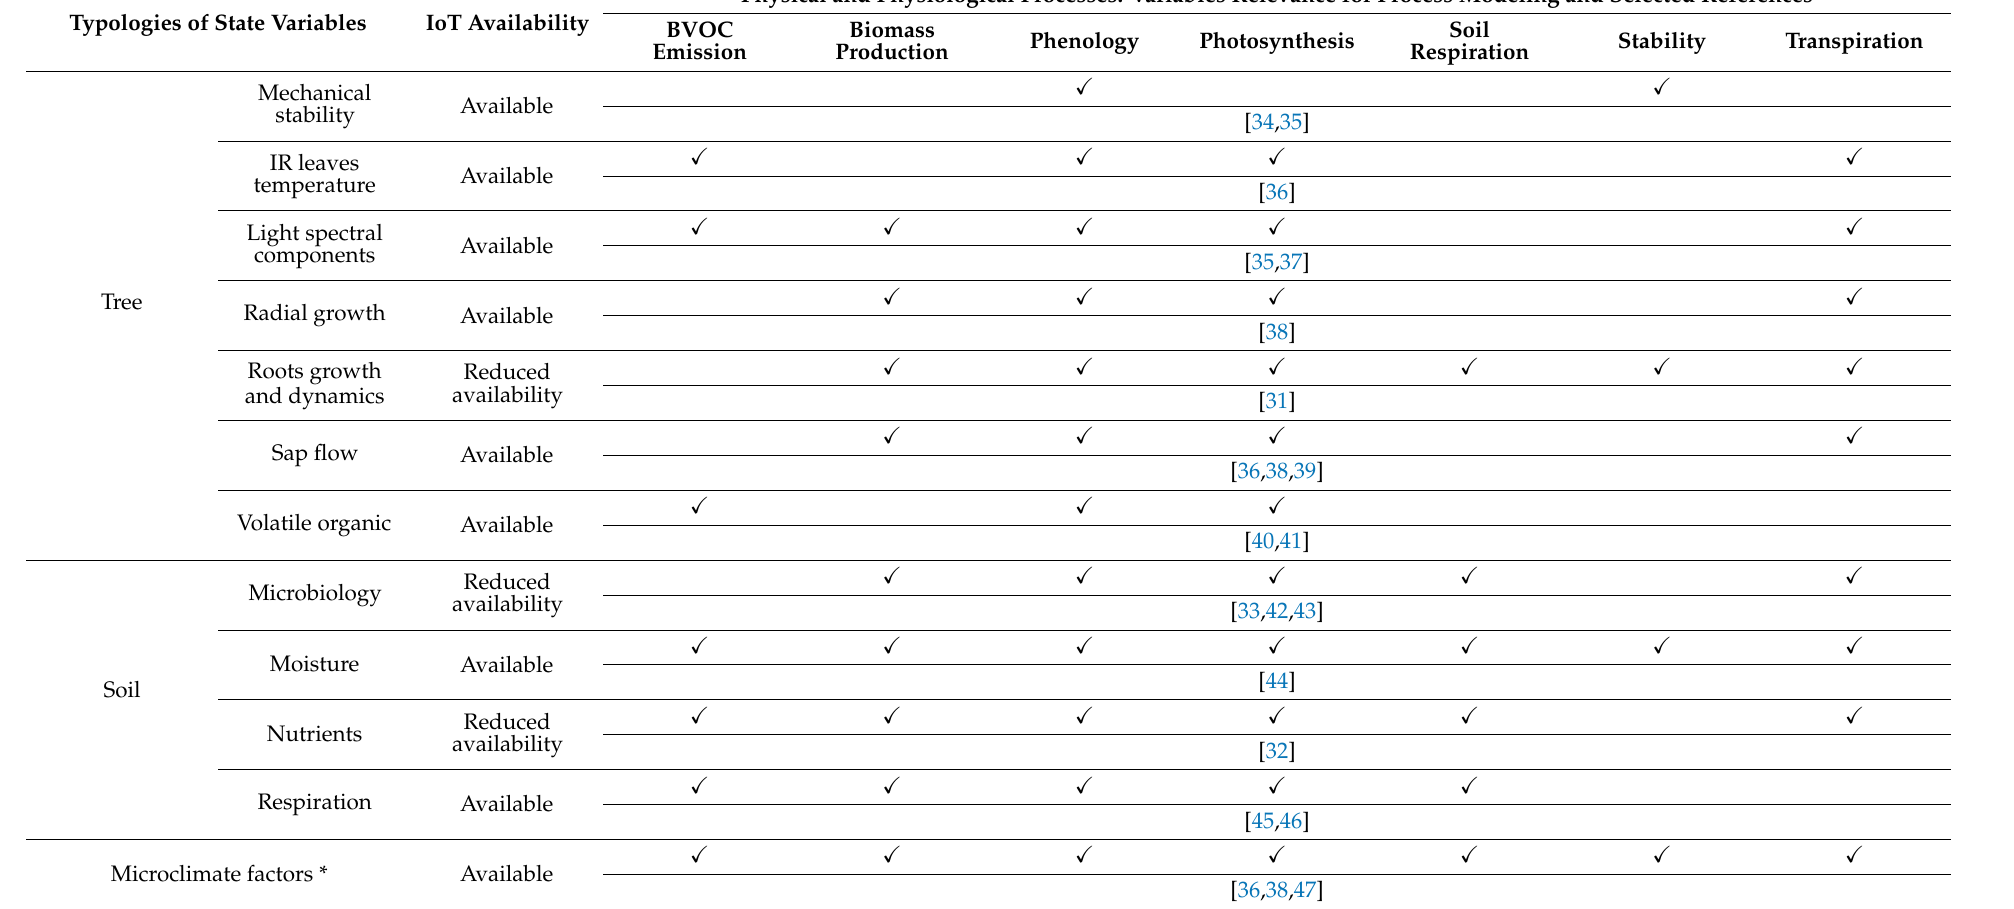
Table 1. Twinning the tree. The table reports the state variables and the related IoT availability to realize the real-virtual socket. It also indicates the main relevance ( (cid:88) ) of the variables to model the physical and physiological processes for the tree virtual entity, and it provides selected references for each state variable